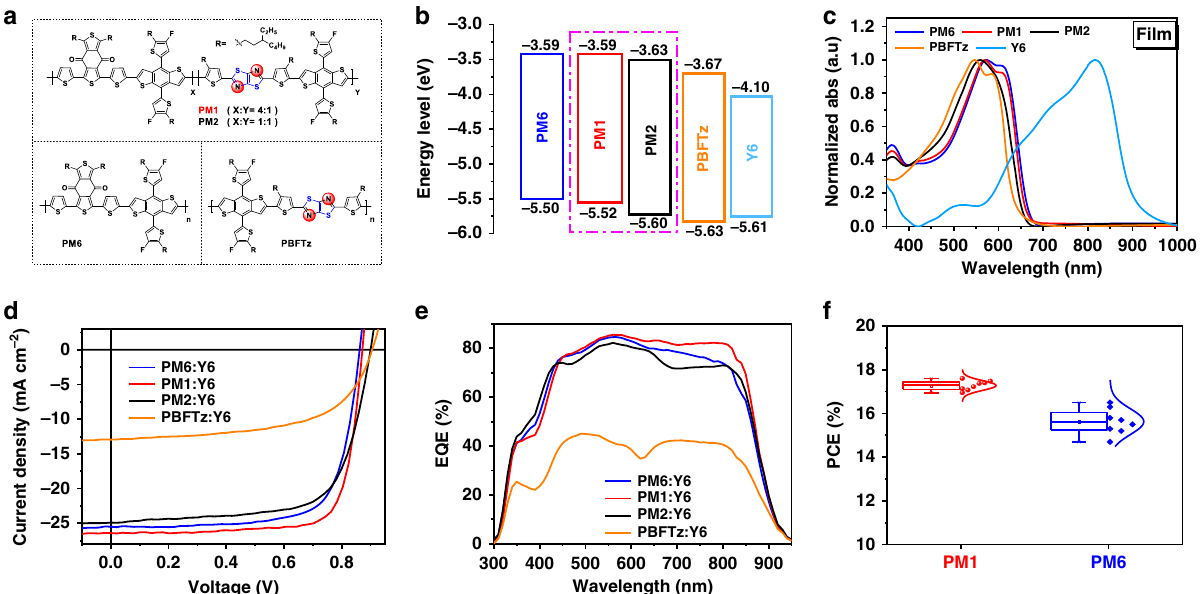
Fig. 1 Chemical structures and optical and electrochemical and photovoltaic properties. a Chemical structures of the donor polymers. b Cyclic voltammetry-derived energy level diagram. c UV-vis absorption spectra of donor polymers and Y6 neat fi lms. d The J – V characteristics of OSCs with different polymers that have various TTz contents. e The EQE spectra of the OSCs. f Statistical histograms of PCEs measured for polymer: Y6-based cells with different polymer batches. Table 1 The photovoltaic parameters of OSCs with different polymers under the illumination of AM 1.5 G, 100 mW cm – 2 . Devices